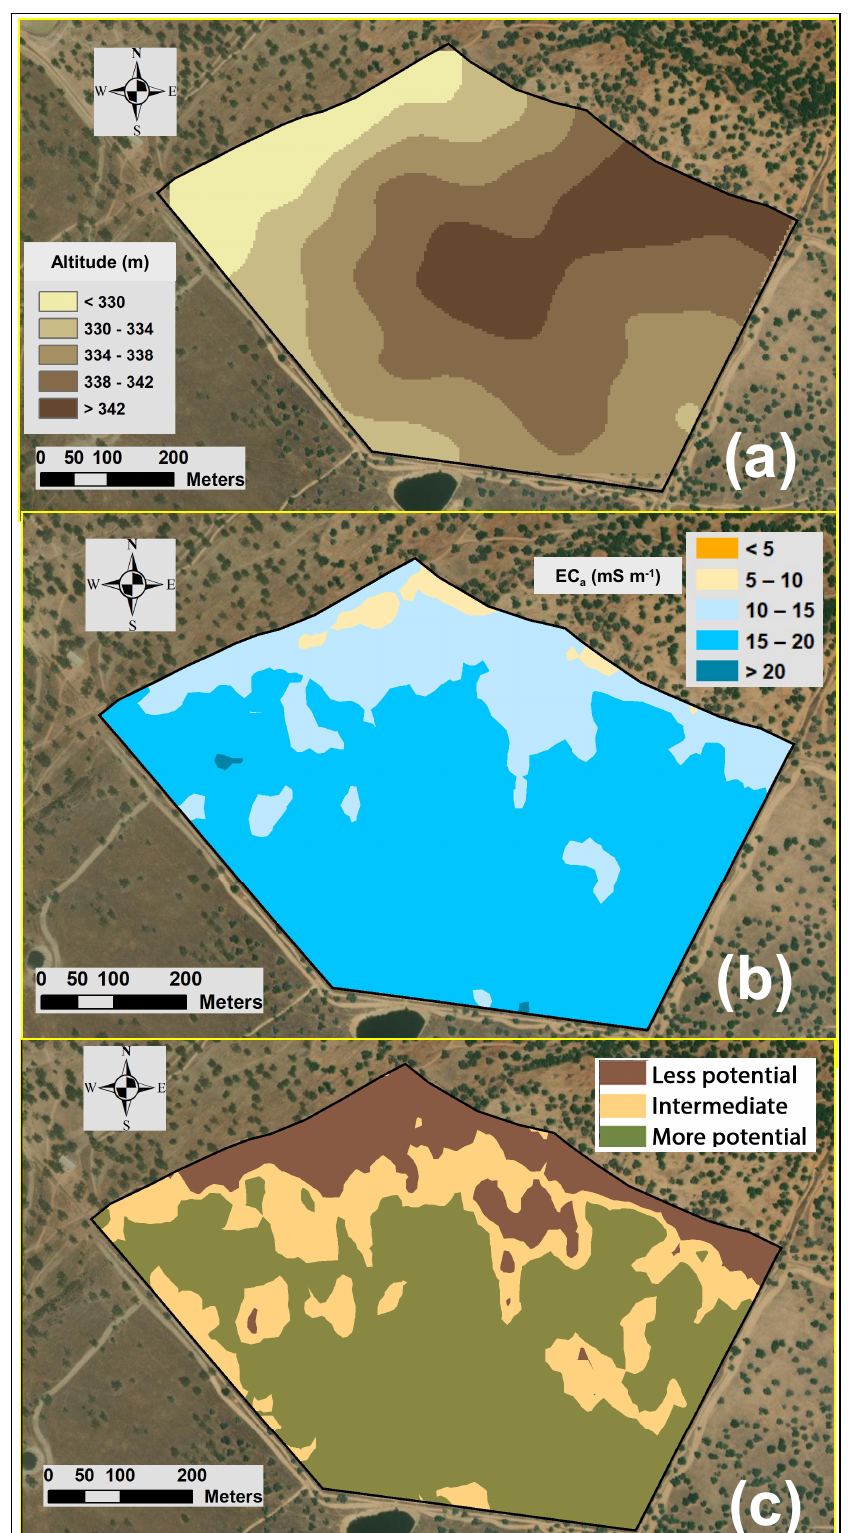
Figure 7. Altitude ( a ), soil apparent electrical conductivity (EC a ; ( b )) and homogeneous management zones ( c ) of “Cubillos” experimental field.